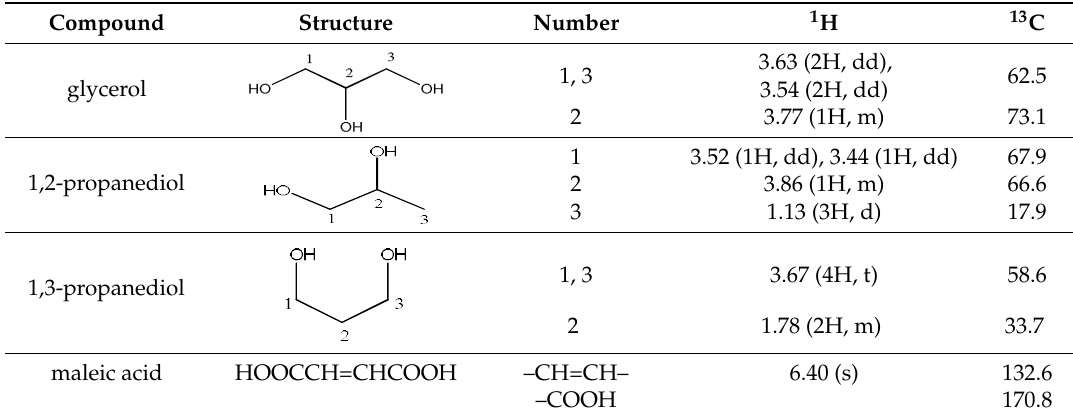
Table 1. Resonance signal assignments of glycerol, maleic acid, 1,2-propanediol, and 1,3-propanediol. Compound